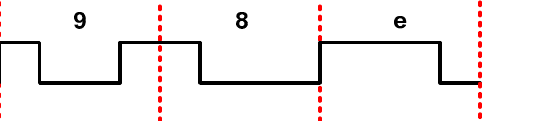
Figure 7. Data outcoming from image sensor to FPGA when train signal is set to high and training word is X“98e”.